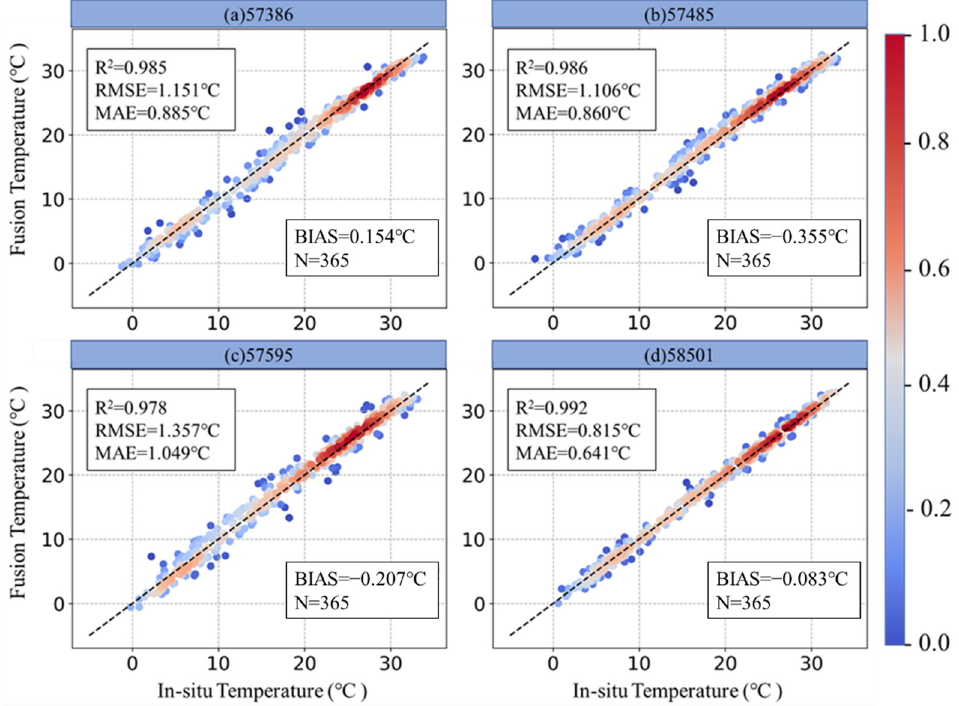
Figure 6. The density scatter plots and statistical metrics for four randomly selected validation sta- tions. The x and y axes represent in-situ ground measurements and fusion temperature, respectively. The red color represents dense concentration of scatters.